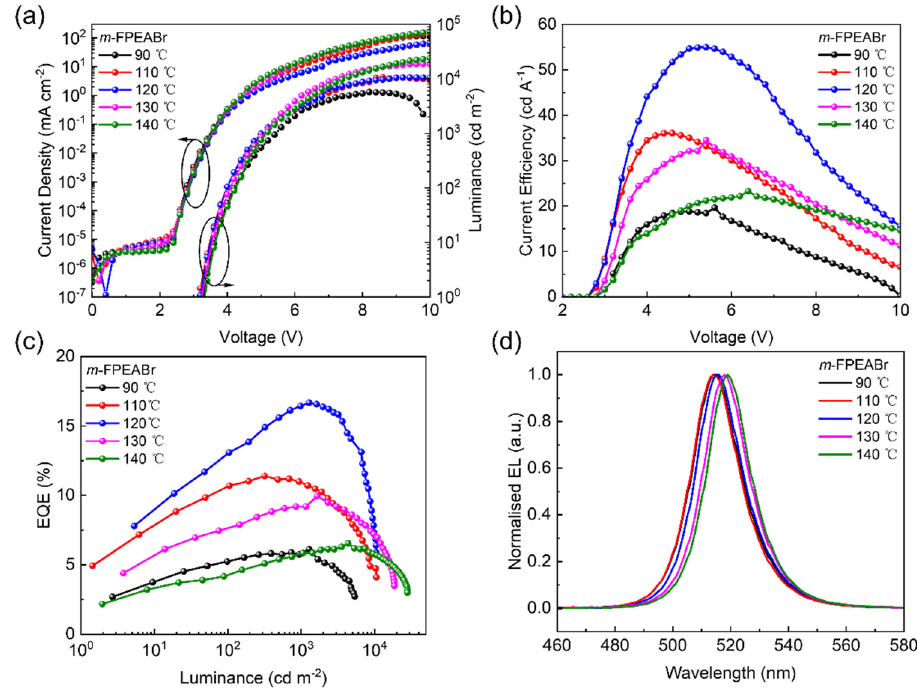
Figure 3. Performance of quasi-2D PeLEDs based on 80% m -FPEABr at different annealing temperatures. ( a ) C-V-L characteristics. ( b ) CE-V characteristics. ( c ) EQE-L characteristics. ( d ) EL spectra at 6V bias voltage.